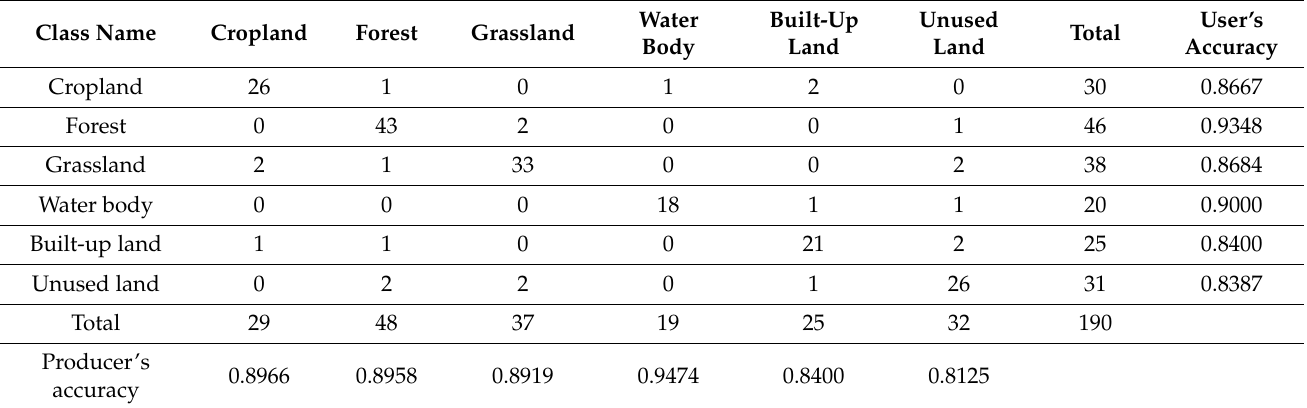
Table 2. Error matrix for the classification method in